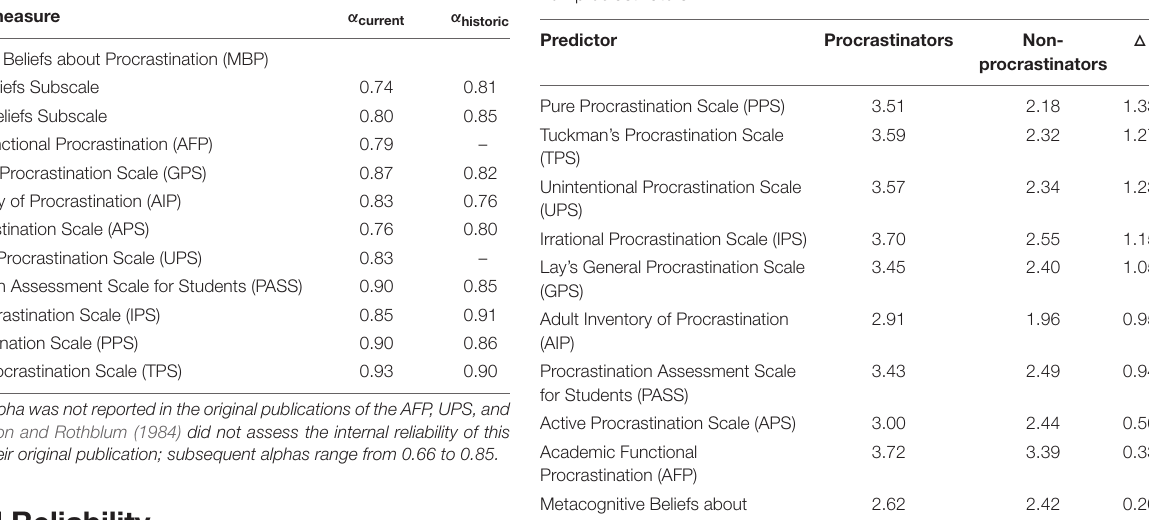
TABLE 3 | Cluster means illustrate the degree to which individual self-report measures of procrastination differentiated procrastinators from